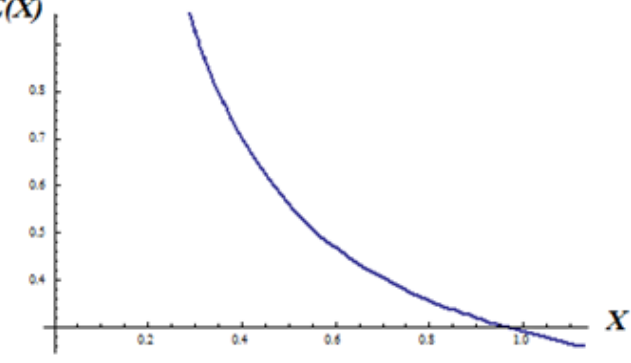
Figure 11. The distribution of the cross-sectional area A ( X ) in the Λ -space.